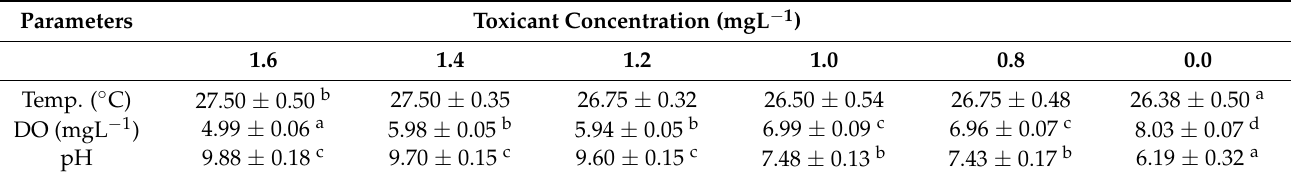
Table 3. Mean water quality parameters.